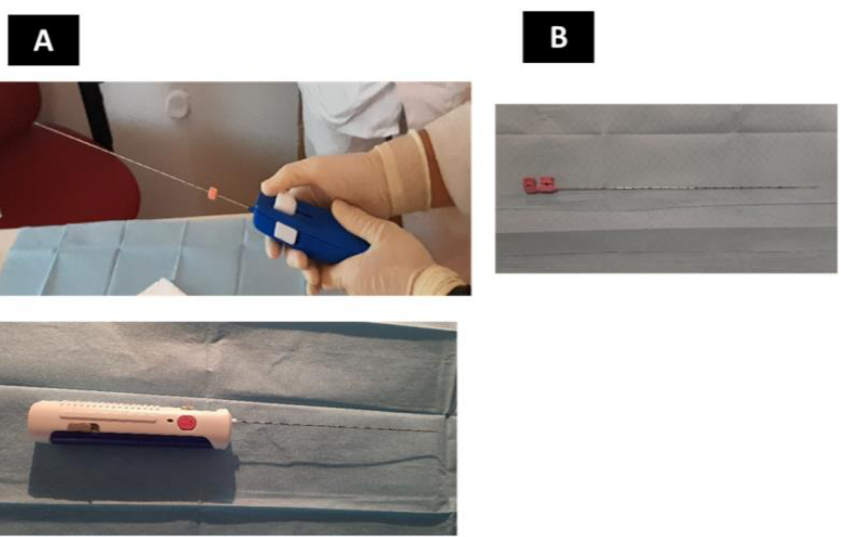
Figure 2. Puncture/drainage needle ( A ) and 18G automatic or semi-automatic biopsy device with a length of 20 – 25 cm and a penetration depth of 12 or 22 mm ( B ).